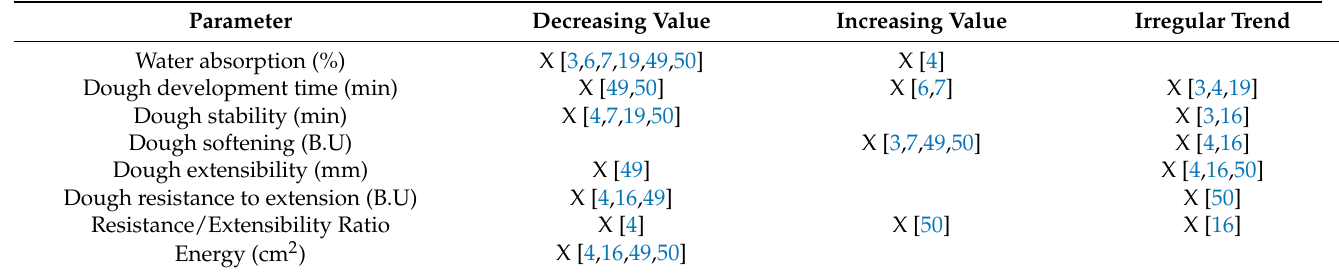
Table 1. Rheological characterization (Brabender Farinograph© and Brabender Extensograph©) of wheat-sorghum blends with increasing sorghum